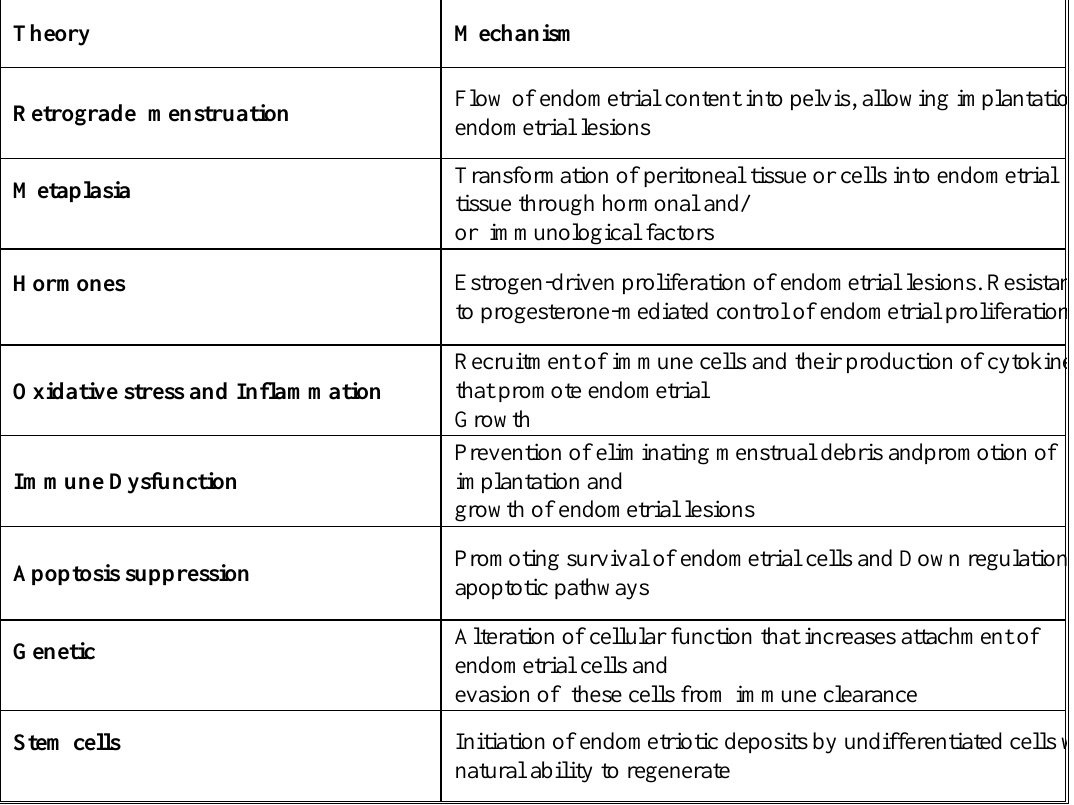
Table (1): Mechanism of the different theories in the pathogenesis of endometriosis